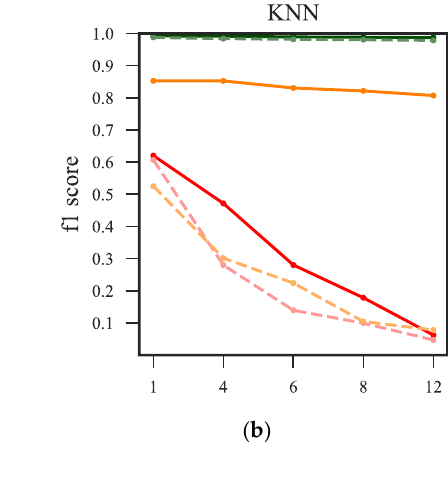
Figure 6. f1 scores per flood warning state ( No-alert , Pre-alert and Alert ) for all combinations of ML techniques across lead times. ( a ), Logistic Regression ( b ), K-Nearest Neighbors, ( c ) Random Forest, ( d ) Naïve Bayes, and ( e ) Multi-layer Perceptron. The brightest and dashed lines in each subfigure (color coding) represent the scores for the test subset.